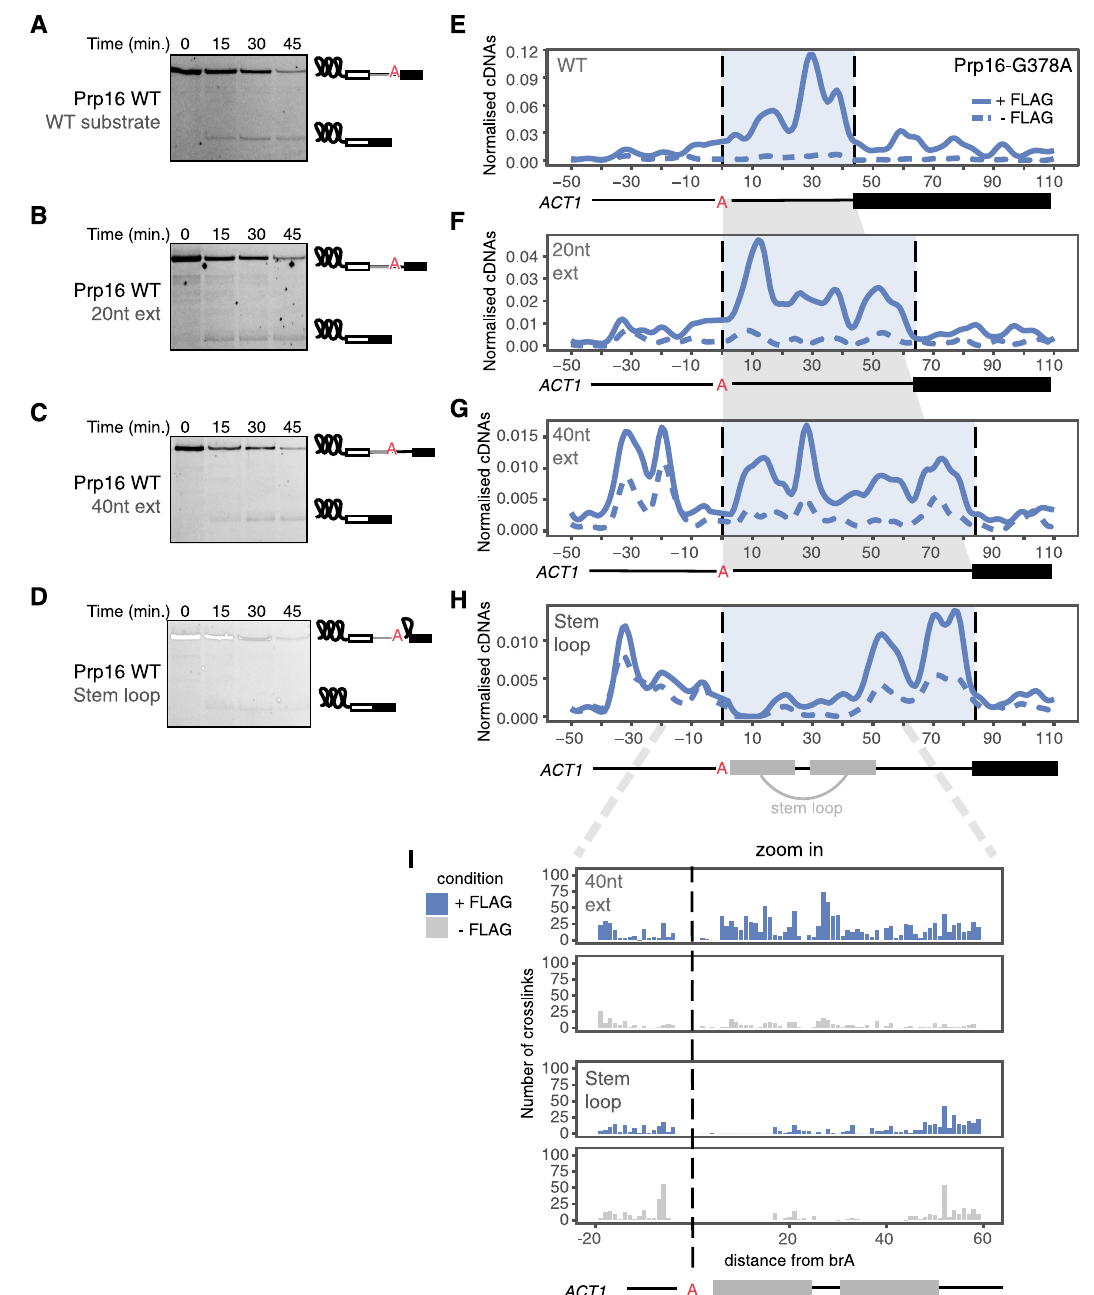
Fig. 4 Prp16 binds the entire available single-stranded RNA between brA and the 3 ′ -SS in ACT1 extended substrates. A – D All versions of the extended ACT1 substrate are capable of being spliced. Splicing assays were performed in a Prp16-WT background. Only splicing products containing the second exon are visible, as the 3 ′ end of the transcript is fl uorescently labelled. Gels are representative of two biological replicates. E – H Mapping of the psiCLIP data generated using Prp16-G378A mutant protein and various forms of the ACT1 splicing substrate, including arti fi cial extensions between the brA and the 3 ′ - SS. The splicing substrates are aligned onto the brA, and the distance between the brA and the 3 ′ -SS is highlighted in light blue. The smoothed lines show the truncation events normalized to endogenous yeast RNA, with the untagged signal subtracted from the tagged signal. Lines were Gaussian smoothed with a window size of ten nucleotides. Positions along the transcript are shown relative to the brA. The crosslinking signal spreads across the whole length of the sequence between the brA and 3 ′ -SS. I Zoom in on the region around the brA shows the almost complete loss of crosslinking downstream of brA in the stem – loop reads containing the canonical splice junction, compared with a ACT1 , respectively, with binding extending as far as + 40 maximum of 0.09% junction reads for the C * complex nucleotides (Fig. 5G, H and Supplementary Fig. 6A). The binding (Supplementary Fig. 6B). We found sharp binding peaks in the region determined by psiCLIP is in perfect agreement with the second exons of both splicing substrates at + 10 and + 20 binding site implied for UBC4 by the complex P cryo-EM nucleotides downstream of the exon – exon junction in UBC4 and structure, and contains positions + 10, + 17, + 22, and + 35 on the